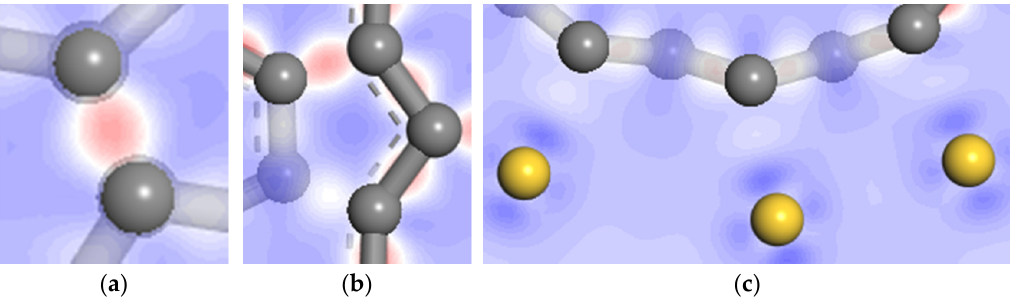
Figure 14. Charge density difference at the interface of DWCNT contacting with gold. ( a ) region A; ( b ) region B; ( c ) region C.